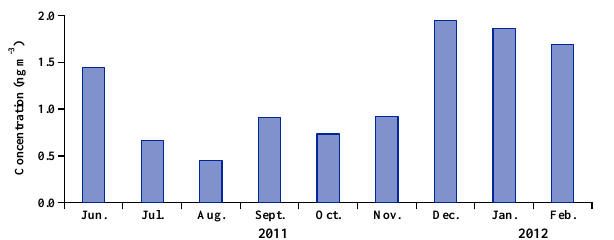
Fig. 2. Monthly variation of Hg P concentration during June 2011– February 2012.